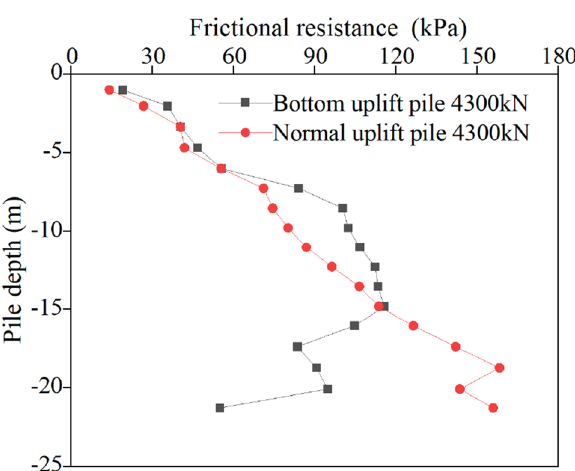
Figure 12. Friction resistance in the second stress stage.